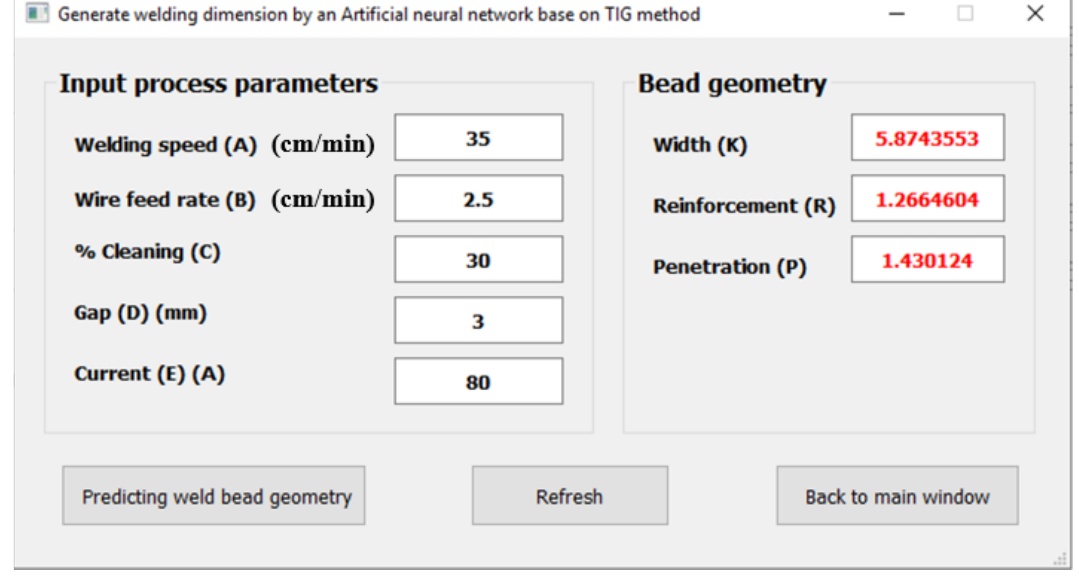
Figure 10. Screenshot of the TIG welding module of the developed predictive system.